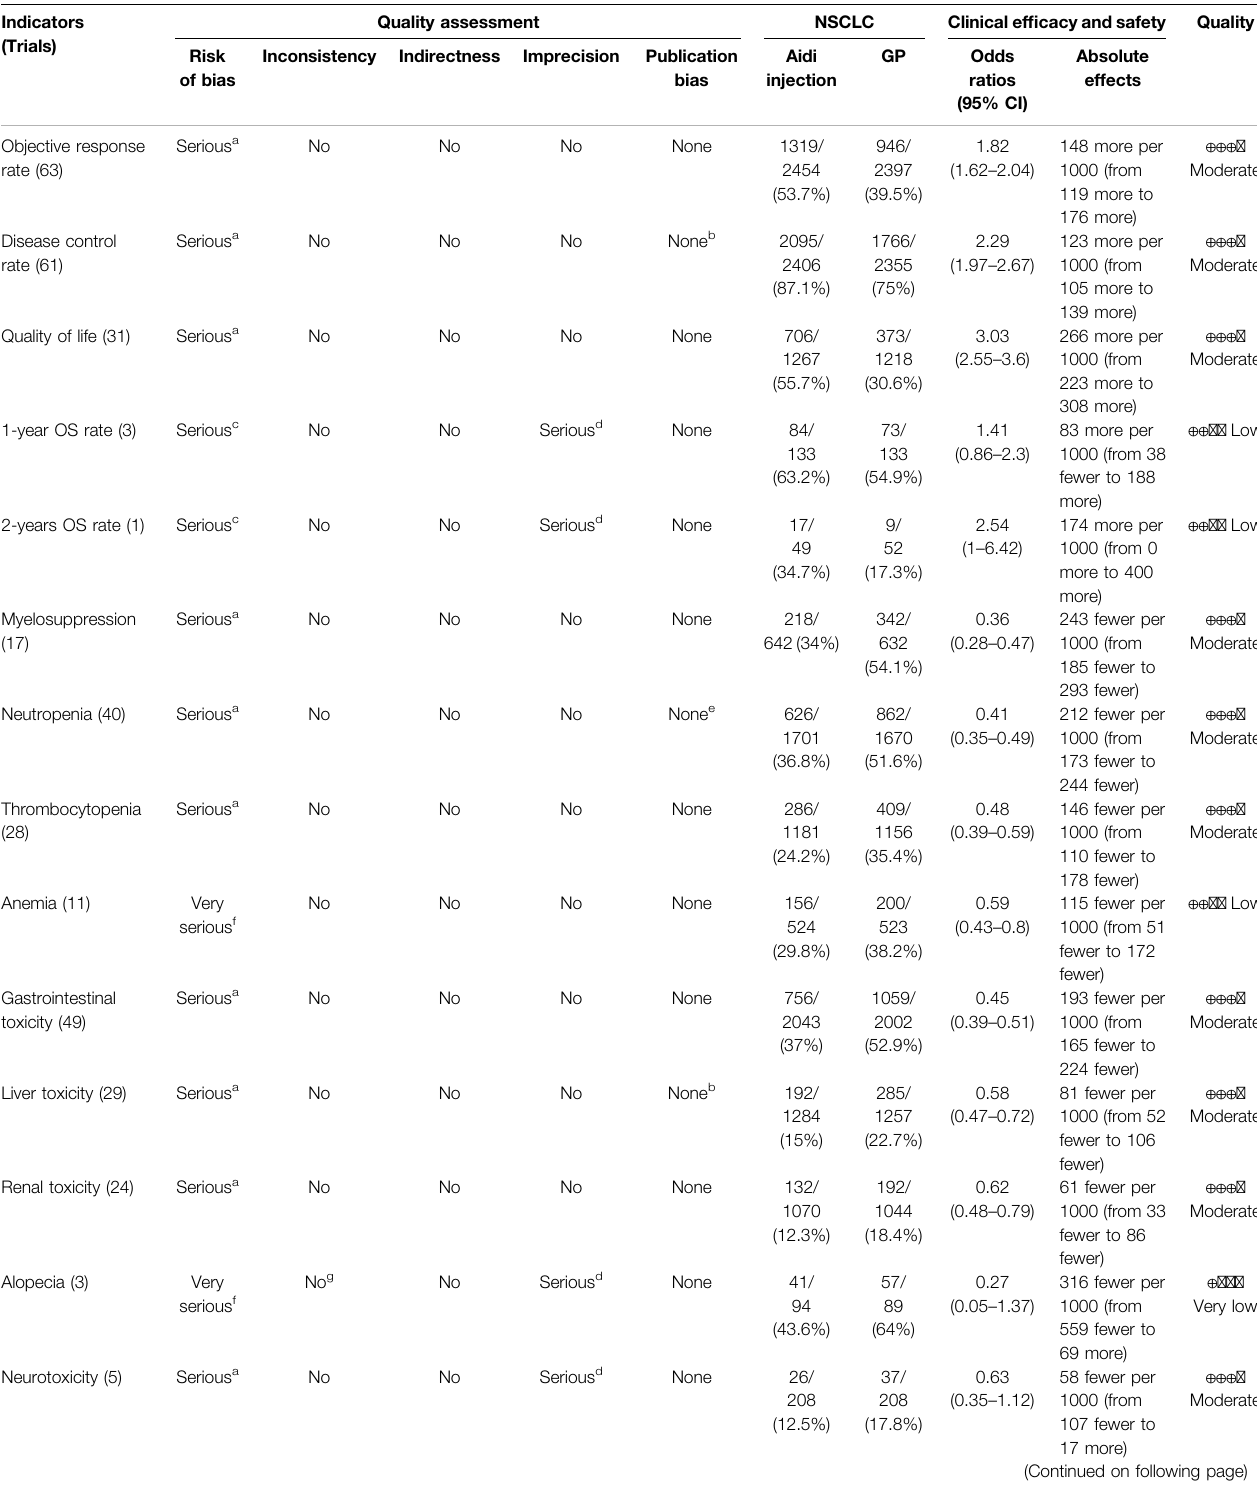
TABLE 5 | GRADE evidence pro fi le. Table 5A. The clinical ef fi cacy and